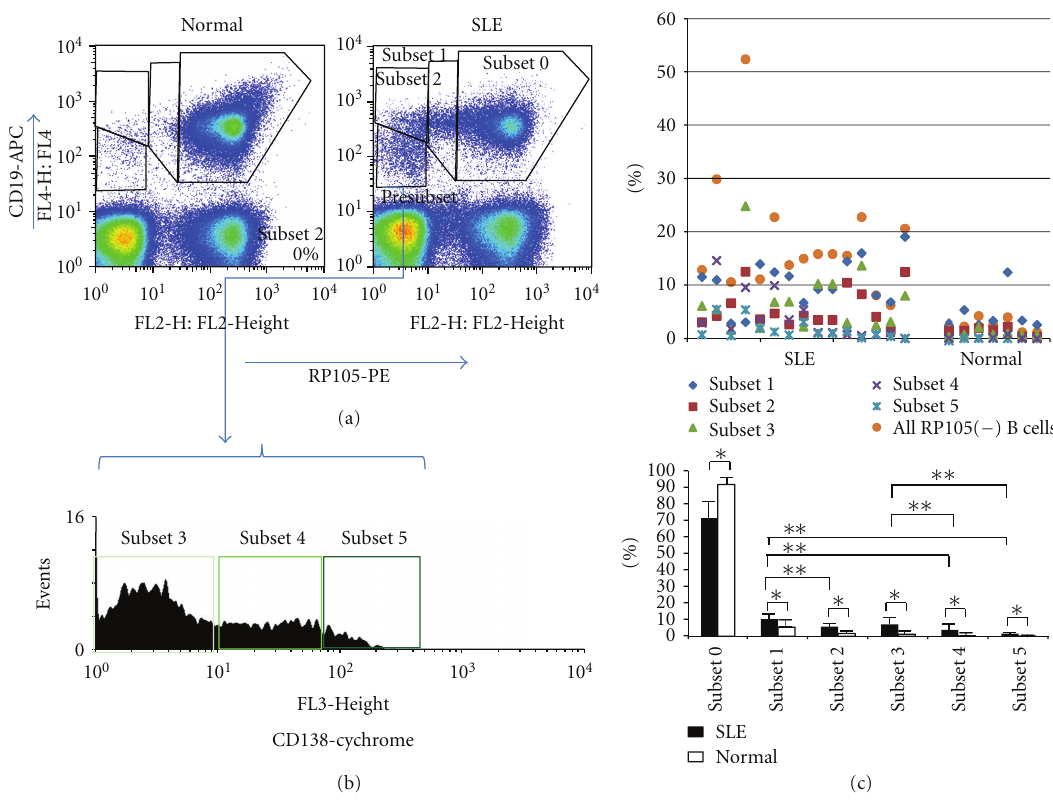
Figure 1: Subsets of RP105( − ) B cells. (a) Representative flow cytometric profiles of RP105 expression on CD19(+) B cells from an active SLE patient and a normal subject. The population was subdivide (1) subset 1; CD19(+)RP105(int), (2)subset 2; CD19(+)RP105( − ), and (3) presubset; CD19(low)RP105( − ). (b) CD138 levels after gating CD19(low)RP105( − ) presubset. The presubset cells were further subdivided into 3 subpopulations, subset 3; CD138( − ), subset 4; CD138(int) and subset 5; CD138(++). (c) The percentages of subsets in PB of each patient and normal subject. ∗ P < 0 . 05, ∗∗ P < 0 .